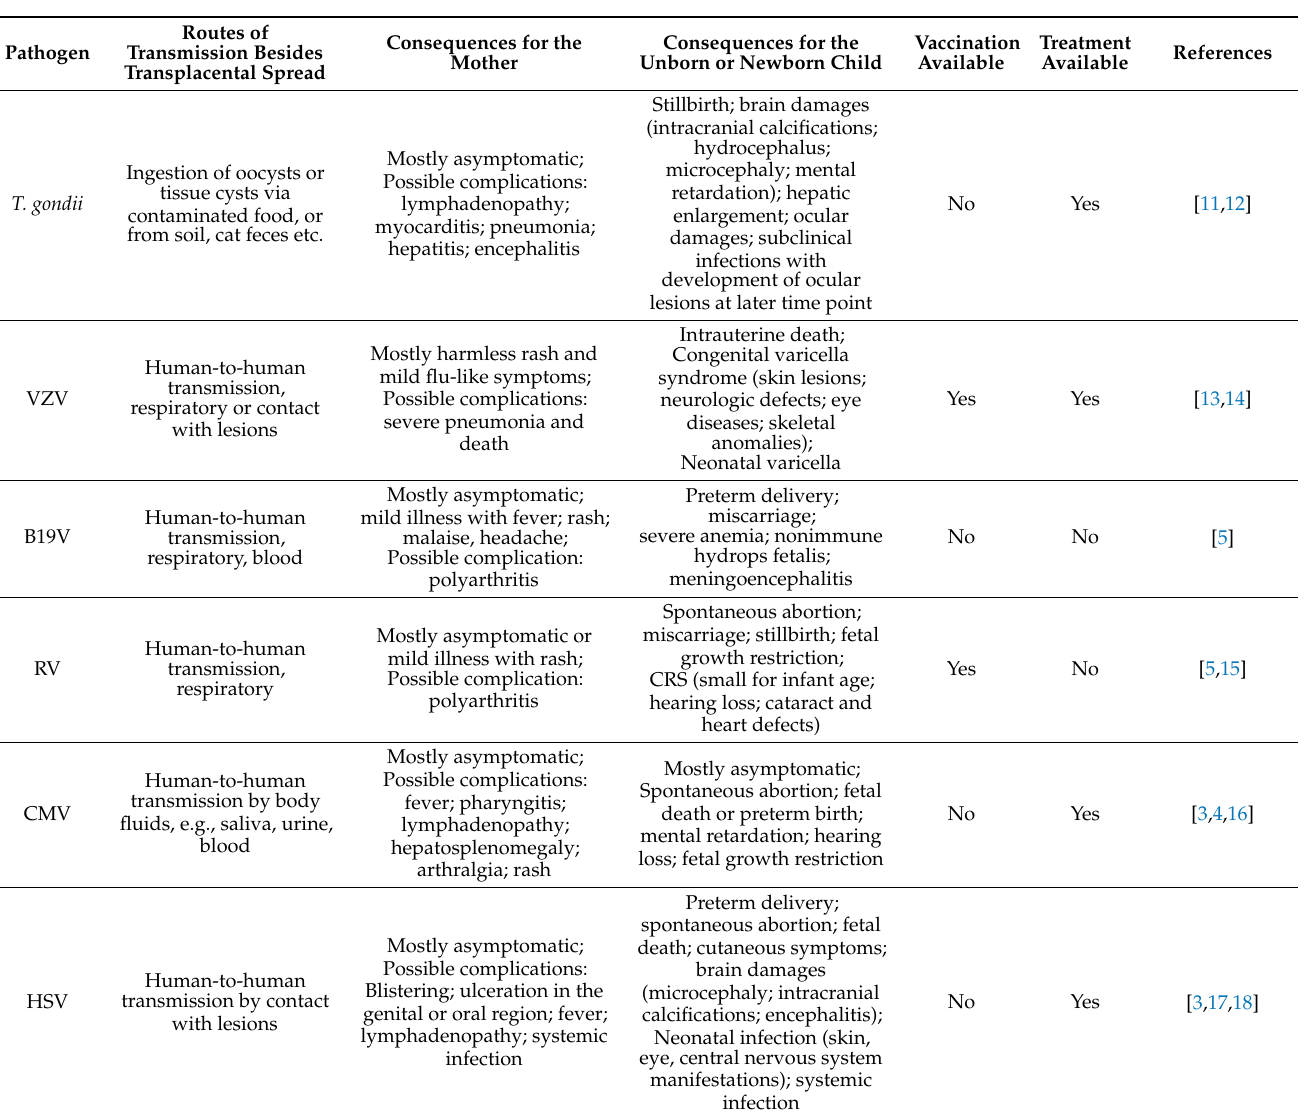
Table 1. Overview of important ToRCH pathogens. B19V = Primate erythroparvovirus 1; CMV = Cytomegalovirus; HSV = Herpes simplex virus; RV = Rubella virus; T. gondii = Toxoplasma gondii ; VZV = Varicella zoster virus; CRS = congenital rubella